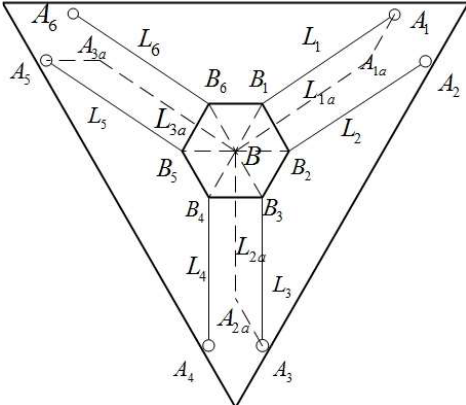
Figure 3. Schematic diagram of the equivalent model.